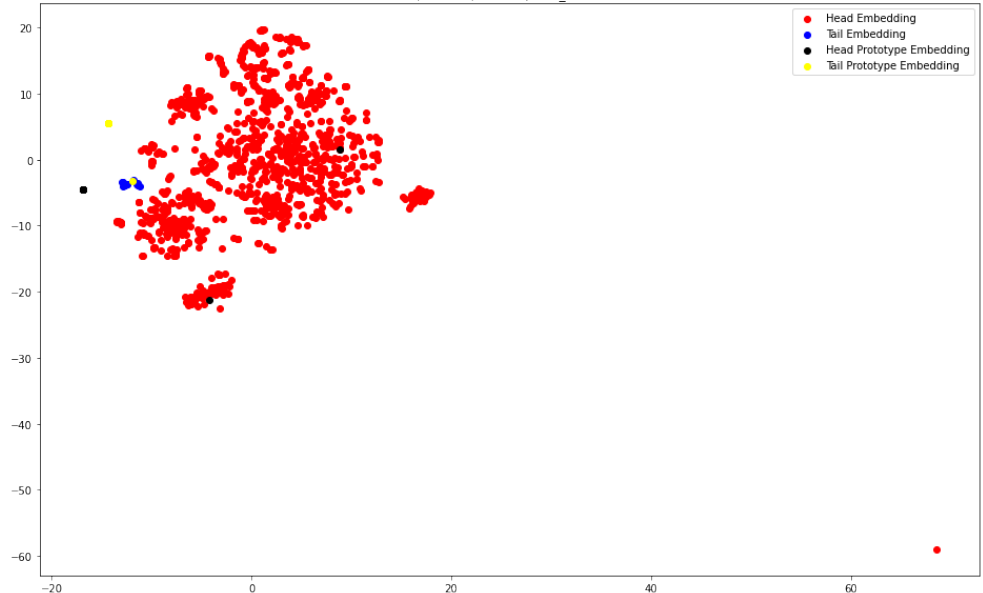
Figure A2. A total of 1,127 different head entities, 13 different tail entities, and 1151 records in the training